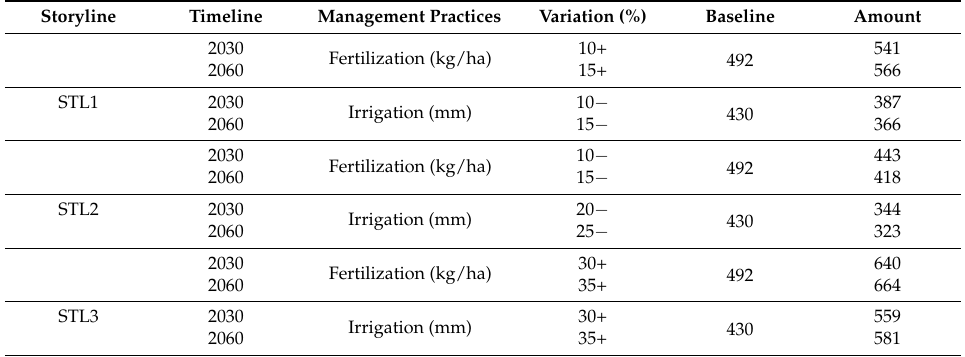
Table 3. The input values used for simulating the storylines in the Soil Water Assessment Tool (SWAT).